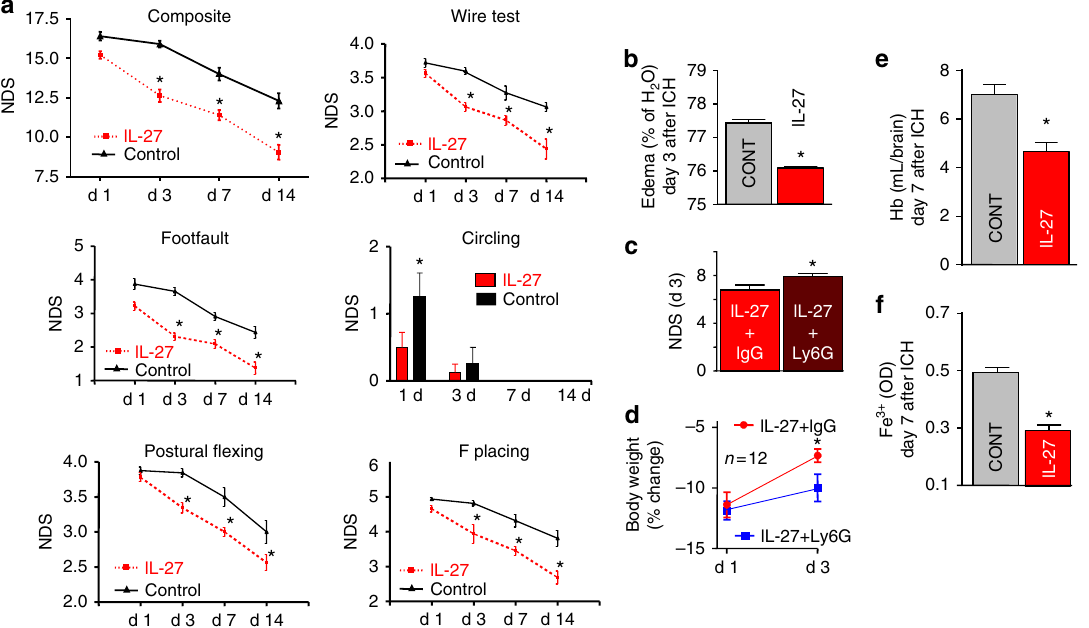
Fig. 4 The therapeutic effect of rIL-27 in a clinically relevant mouse model of ICH. ICH in mice was induced using autologous blood injection. The rIL-27 treatment was initiated at 30 min after ICH by i.v. injection and then daily by s.c. injection for 6 days, each treatment at 50 ng/kg. The outcome include: a the individual behavioral/NDS of footfault, circling, wire, postural fl exing, and forward placing test, and grand NDS, a composite NDS score on day 1 – 14 after ICH ( n = 8) The data were expressed as mean ± SEM and * p < 0.05 was established using one-way ANOVA followed by Newman – Keuls post-test. b Brain edema (water content) on day 3 ( n = 5); e hemoglobin (Hb) and f iron content in ICH-affected brain (index of hematoma removal) on day 7 ( n = 5). c The grand NDS on day 3 after ICH in mice treated with rIL-27 and with Ly-6G or rat isotype IgG, control. Twenty-four of C57/BJ6 mice were treated with rIL-27 (Biolegend, 577404, a heterodimer of mouse recombinant IL-27 EBI3 and p28 linked by a GGGSGGGSGGGTGGGS linker), 50 ng/kg by i.v. at 30 min and then daily s.c., on day 1 – 3 after ICH. To deplete neutrophils, 12 mice were injected with Ly-6G, a neutrophil neutralizing antibody (BioXCell, 1A8, BE0075) at 500 μ g/mouse at 2, 24, and 72 h after ICH (i.p.). And 12 mice were injected with rat isotype IgG (IgG2a, BioXCell, 2A3, BE0089). The NDS were quanti fi ed with three behavioral tests (postural fl exing, circling, and footfault) 3 days after ICH. d The percent change of body weight on day 3 (compared with the body weight on day 0, right prior to ICH). In b – f , all data were expressed as mean ± SEM. * p ≤ 0.05, compared with the